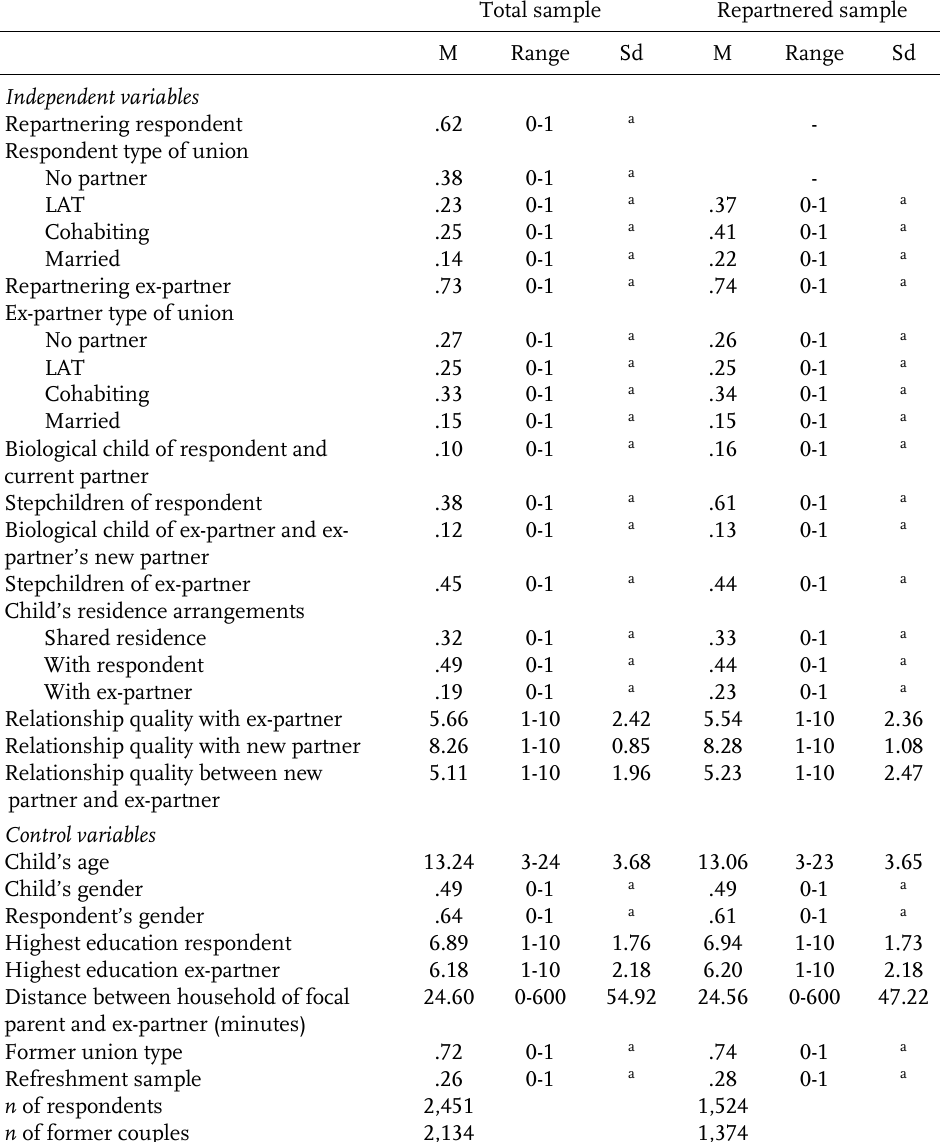
Table 1 : Descriptive statistics of independent and control variables, by sample Total sample Repartnered sample M